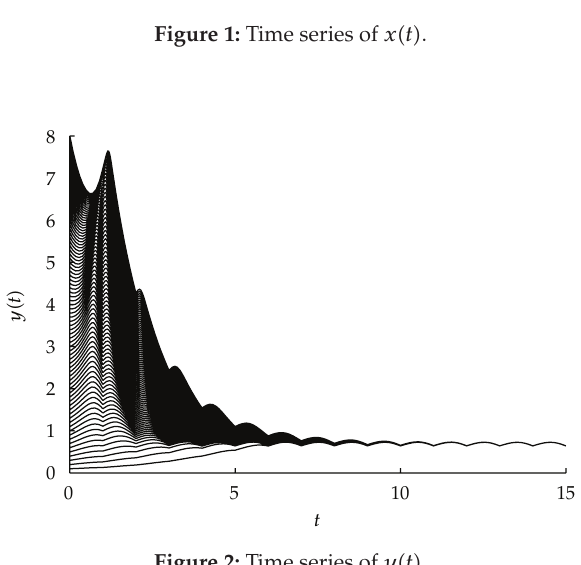
Figure 1: Time series of x (cid:7) t (cid:8) .